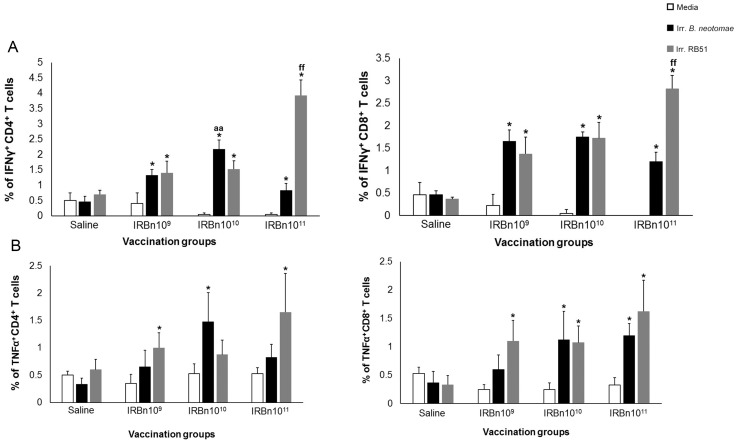
Flow cytometric analysis showing the percentage of interferon-γ secreting (A), and tumor necrosis factor-α secreting (B) CD4+ and CD8+ T cells in the spleens of BALB/c mice immunized with 109 CFU-equivalent or 1010 CFU-equivalent or 1011 CFU-equivalent of gamma-irradiated B. neotomae, or inoculated with saline following in vitro stimulation with media (unstimulated), gamma-irradiated B. neotomae and gamma-irradiated RB51.*Significantly different from the corresponding unstimulated control within a vaccination group (P<0.05). aa Significantly different from the corresponding vaccination groups with irradiated B. neotomae stimulation (P<0.05). ff Significantly different from the corresponding vaccination groups with irradiated RB51 stimulation (P<0.05).